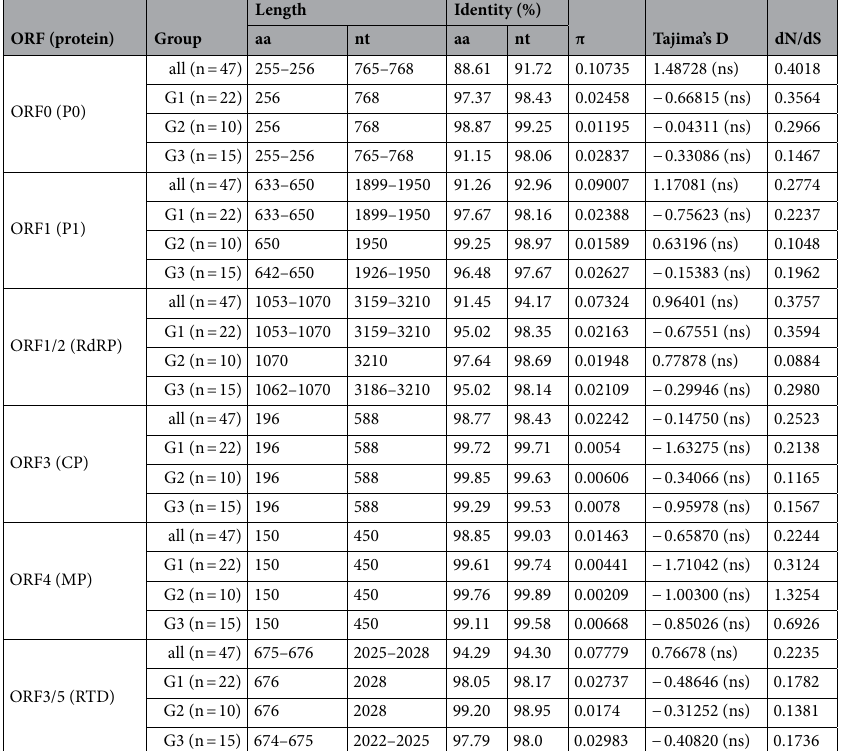
Table 2. The length, identity, nucleotide diversity, neutrality test, and selection pressure on each gene among the overall sugarcane yellow leaf virus (SCYLV) population and each phylogroup. aa, amino acid; nt, nucleotide; π, nucleotide diversity; ns, not significant ( P > 0.05); nonsynonymous/synonymous ratio (dN/ dS) < 1 (negative or purifying selection), dN/dS = 1 (neutral evolution), and dN/dS > 1 (positive